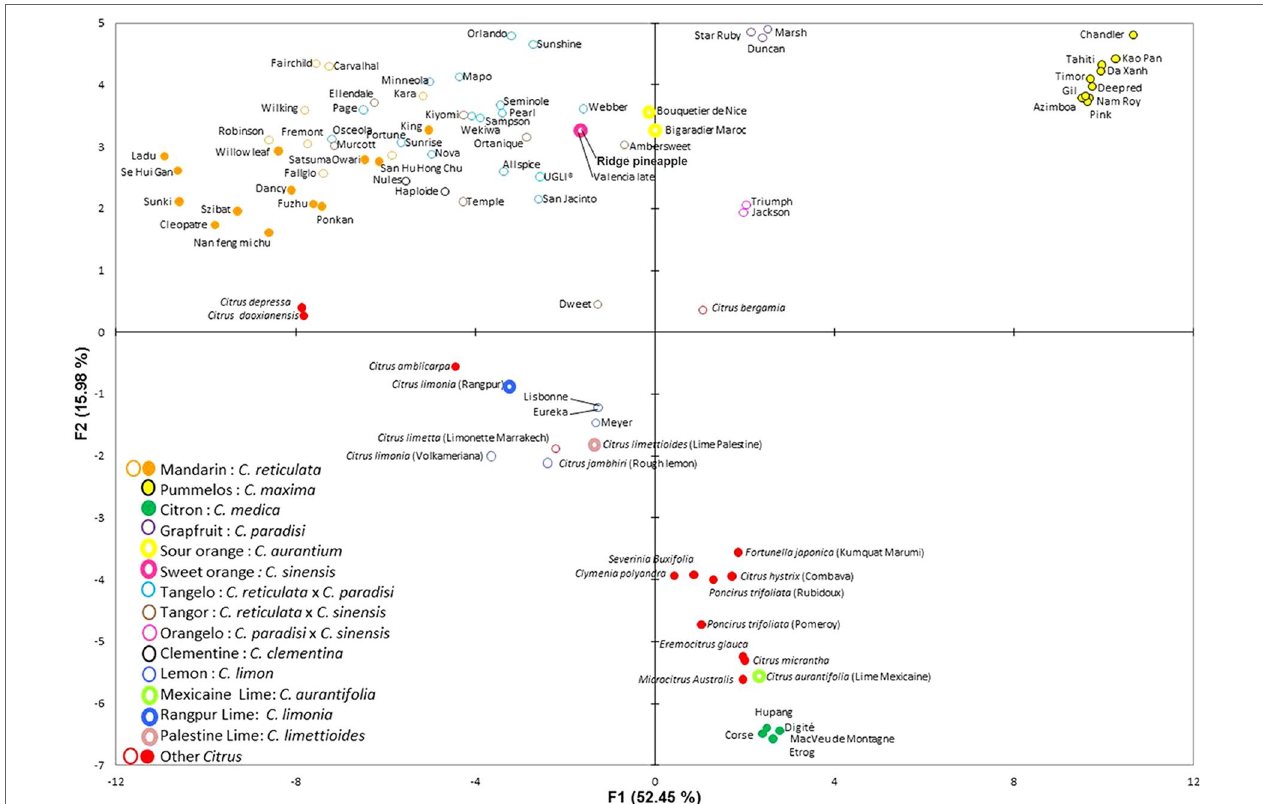
FIGURE 5 | PCA of 92 citrus varieties using 103 nonredundant